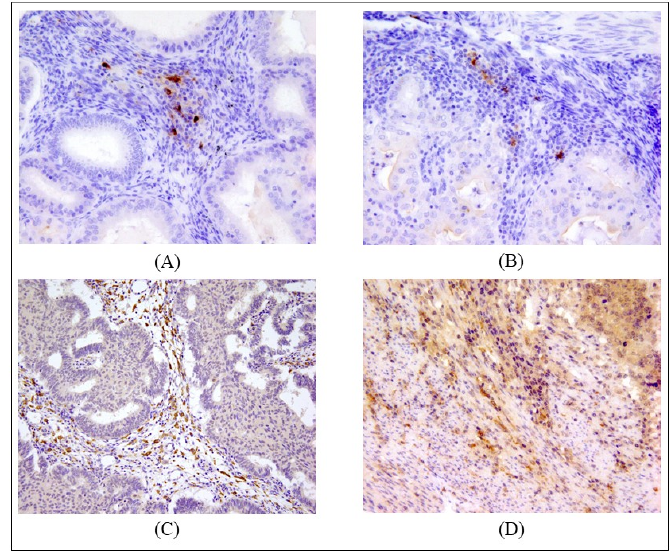
Figure 2. Examples of positively identified DCs infiltrating EC samples. A cell was considered as positively stained if at 40× magnification it had a visible nucleus, dendritic appearance, and intensely colored cytoplasm. ( A ) DC-LAMP+ infiltrating stroma of endometroid cancer at 40× magnification (7 cells/HPF); ( B ) DC-LAMP+ infiltrating border of endometroid cancer at 40× magnification (8 cells/HPF); ( C ) DC-SIGN+ infiltrating stroma of endometroid cancer at 20× magnification; ( D ) DC-SIGN+ infiltrating invasive border of endometroid cancer at 20× magnification. In ( C , D ) a sign of staining can be seen in the cancerous glands and off-target staining in stromal tissues.